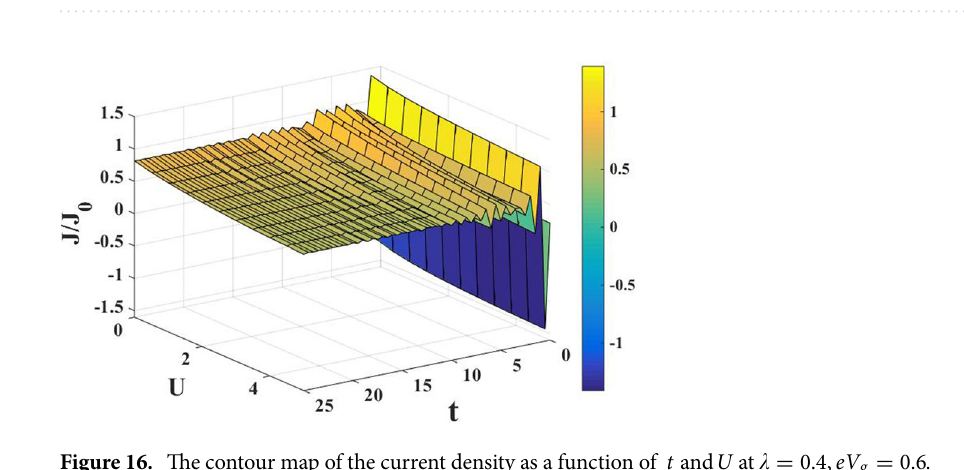
Figure 15. Current density as a function of t and (cid:31) . Three-dimensional plot (left) and contour map (right).